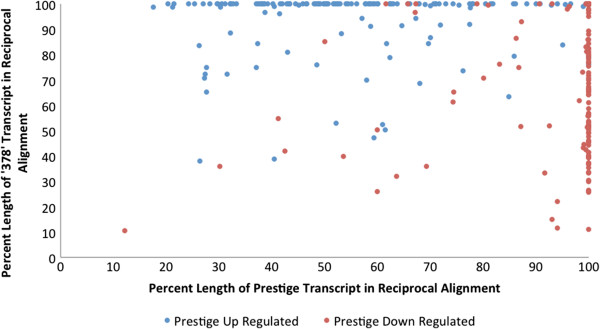
Scatter plot displaying percent length of ‘Prestige’ transcripts aligning to percent length of ‘378’ transcripts. Transcripts shown are those that were a reciprocal match and significant expression change was detected.